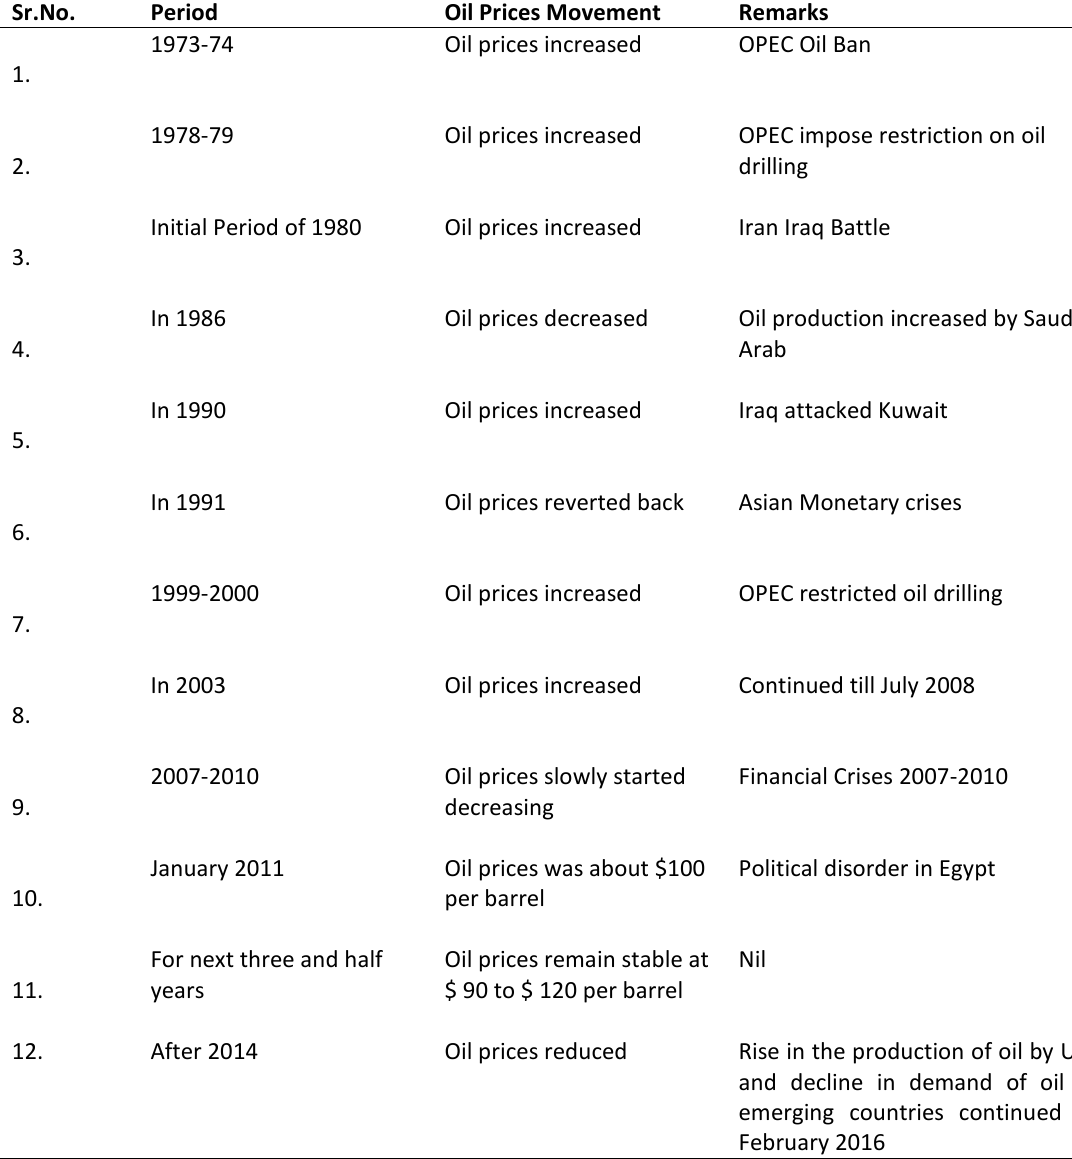
Table 2. Crises during selected time